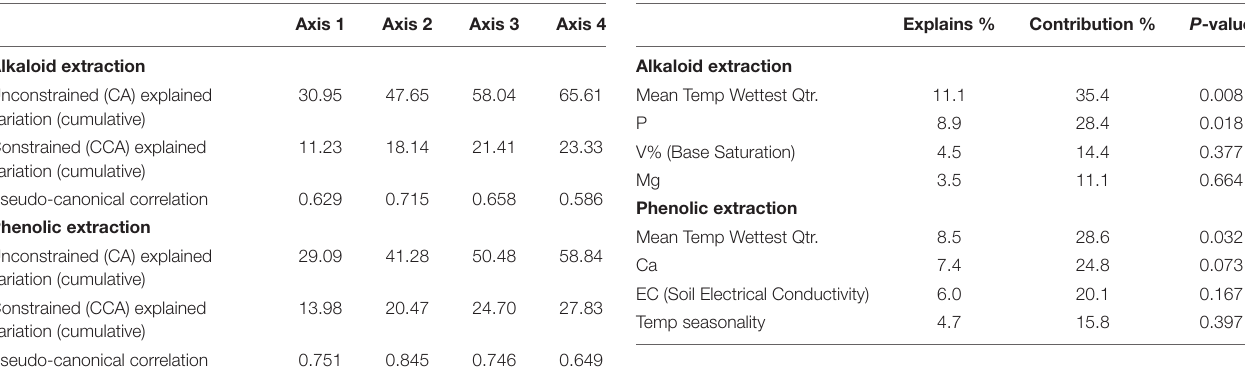
TABLE 2 | Explained variation from axes in the CA and CCA ordination diagrams. TABLE 3 | Interactive forward selection of environmental